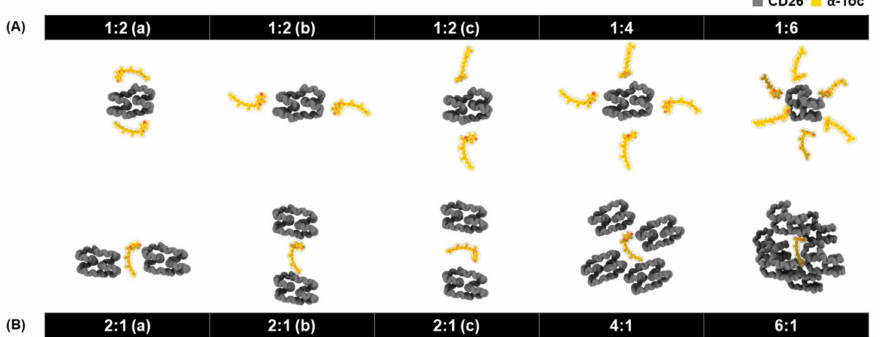
Figure 1. The different initial CD26: α -tocopherol ratios used for the complexes in this study: ( A ) 1:2 (a), 1:2 (b), 1:2 (c), 1:4, and 1:6, and ( B ) 2:1 (a), 2:1 (b), 2:1 (c), 4:1, and 6:1. The complexes were generated by setting the distance between the centers of mass (C m ) of α -tocopherol and CD26 at 20